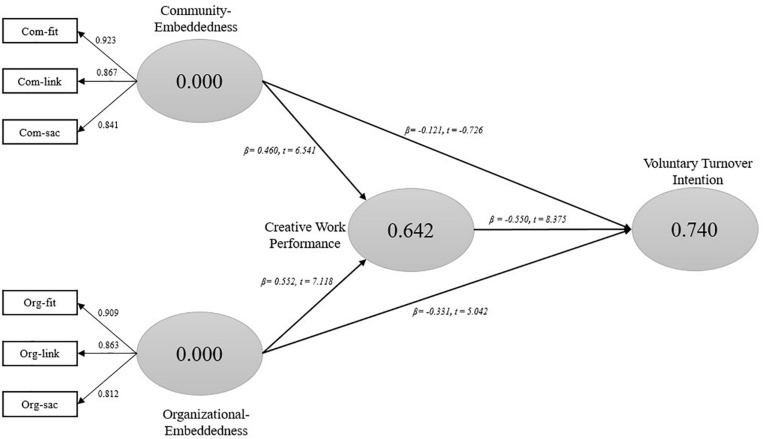
Path model results.